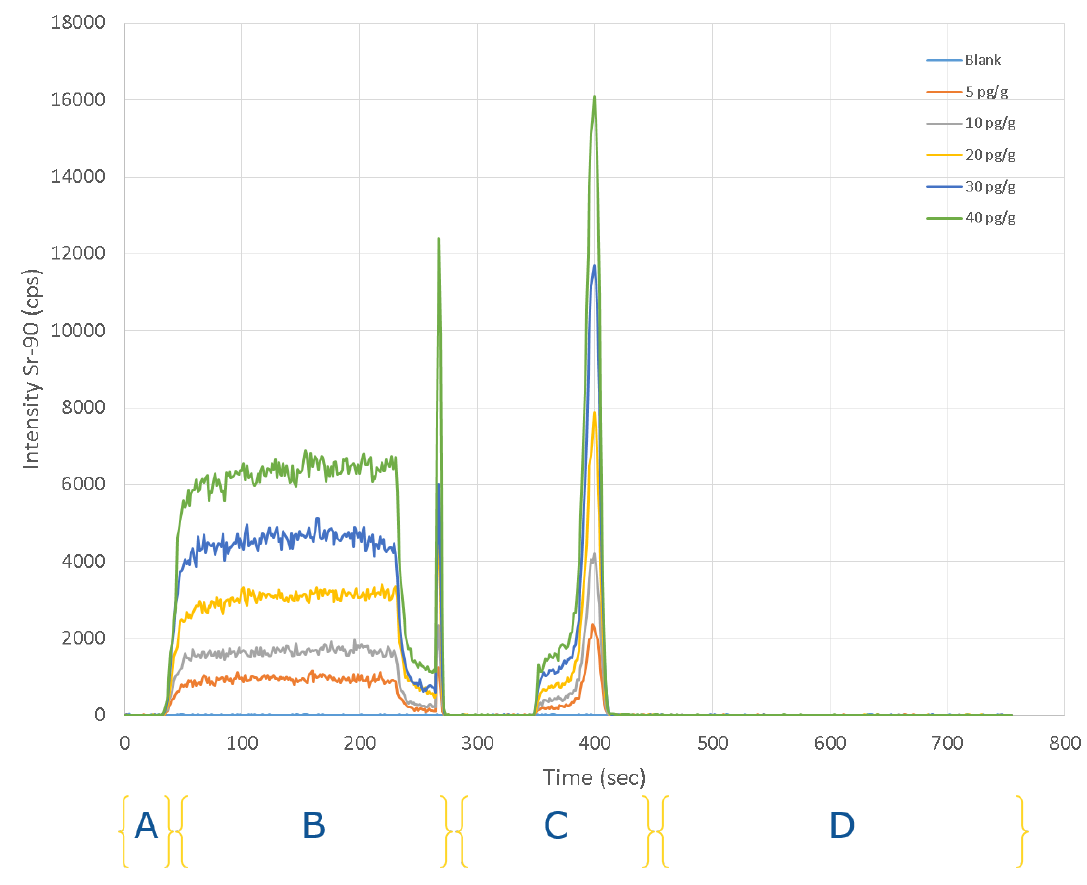
Figure 1. SeaFAST system with ICP-DRC-MS time resolved signal of the different 90 Sr standards solutions. ( A ) sample load to the loops; ( B ) direct mode; ( C ) pre-concentration mode; ( D ) cleaning and pre-conditioning.